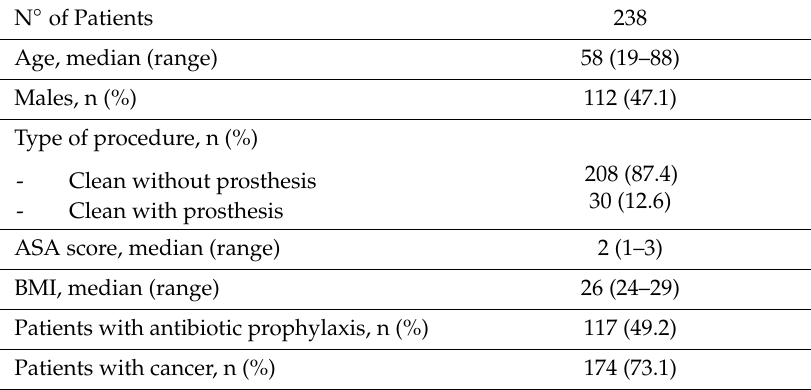
Table 1. Clinical background and demographic features of enrolled